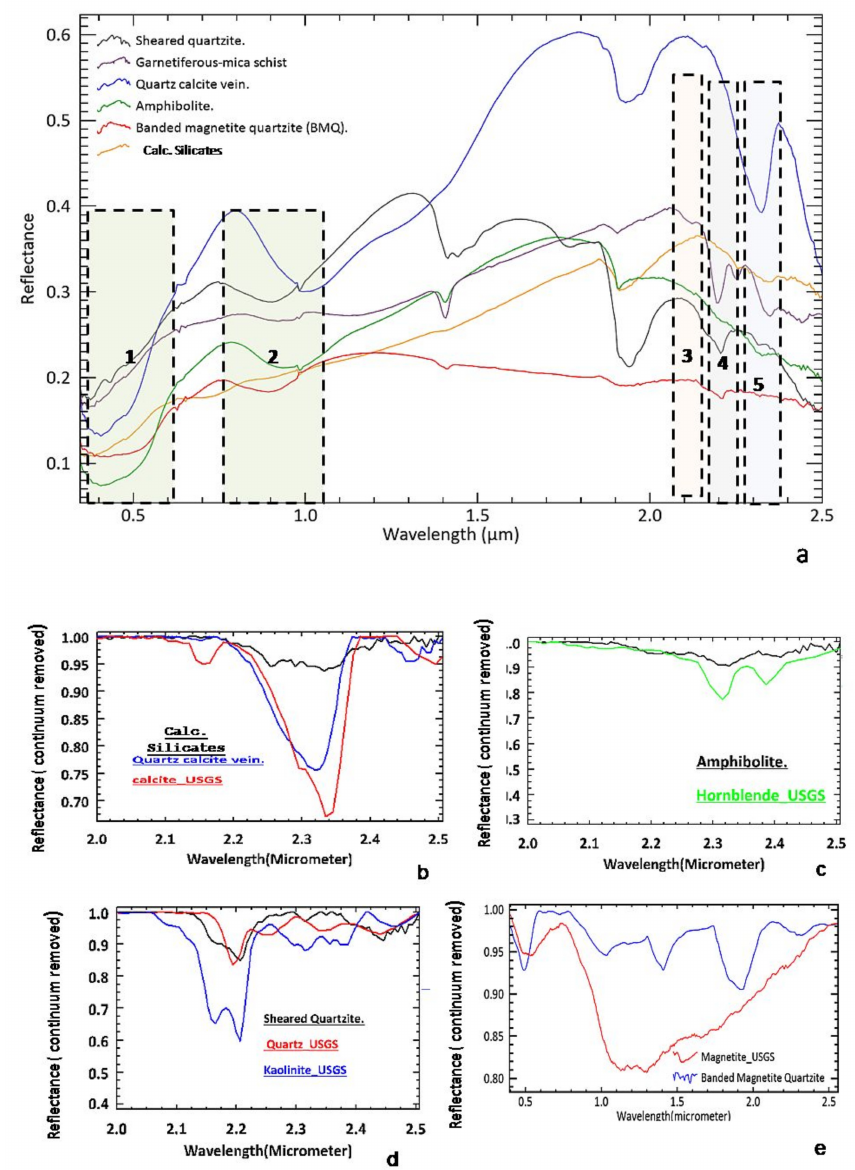
Figure 3. ( a ) Plot of representative spectral profiles of main rock types of the study area. In the plot, each box is used to illustrate schematically the spectral domain of few diagnostic absorption features of main rock type of the study area. Box 1: Wavelength domain of diagnostic spectral feature of BMQ. Box 2: Wavelength domain of diagnostic spectral feature of quartzite (which are sericite rich and sheared). Box 3: Wavelength domain of diagnostic spectral feature of carbonate rich calcareous silicates. Box 4 and 5: Wavelength domain of diagnostic spectral feature of amphibolite. Plots ( b – e ) of representative spectrum of each rock type with the spectra of their constituent minerals are presented to show how the spectral features of dominant and spectrally diagnostic minerals influence the spectral features for differentrock types: b. calcareous silicates; c. amphibolite. d = sheared quartzite; and e = banded magnetite